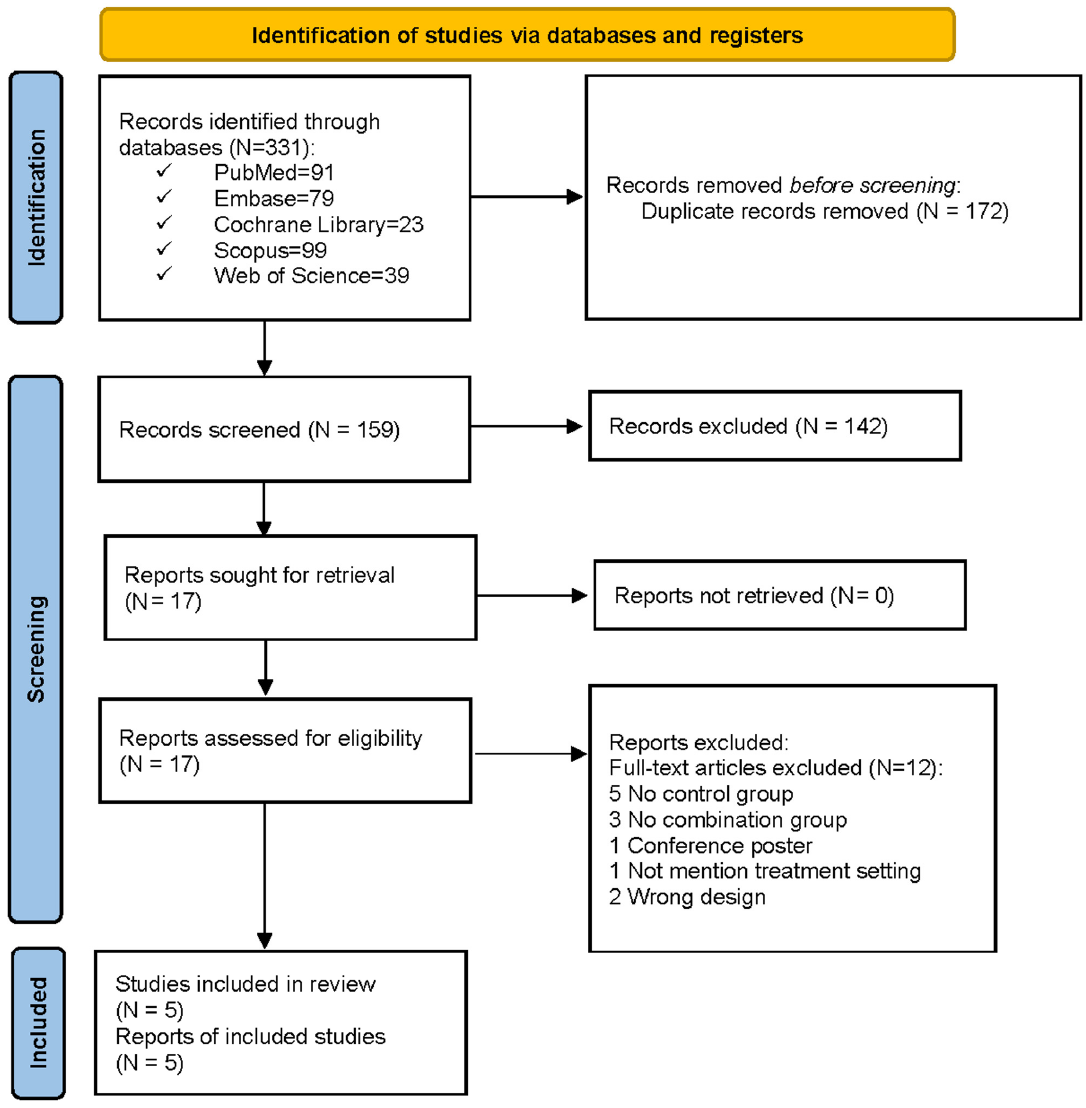
Figure 1. PRISMA flow Figure 1. PRISMA fl ow diagram.